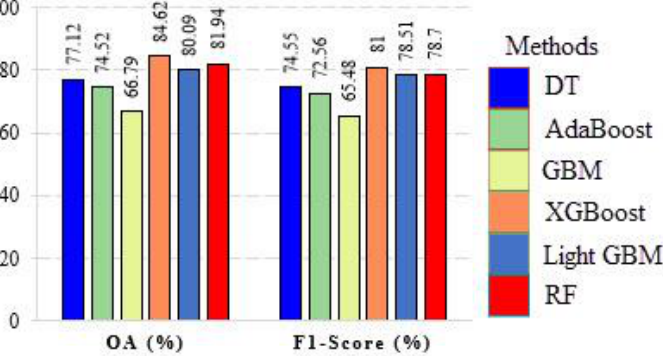
( f ) Figure 18. Classification results for San Francisco data. ( a ) DT, ( b ) AdaBoost, ( c ) GBM, ( d ) XGBoost, ( e ) Light GBM, and